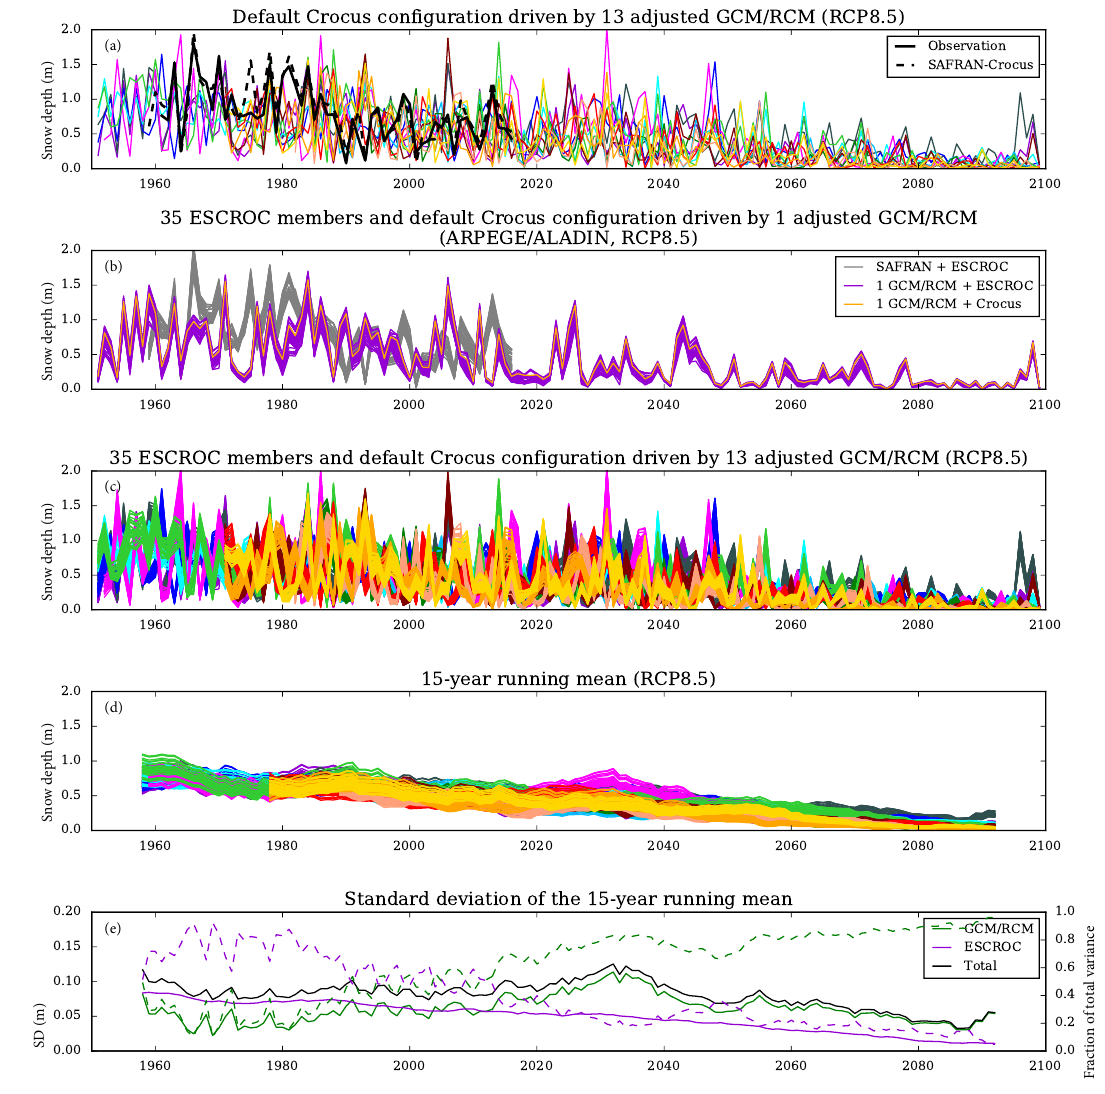
Figure 3. Same as Fig. 2 but using RCP 8.5 GCM–RCM pairs.